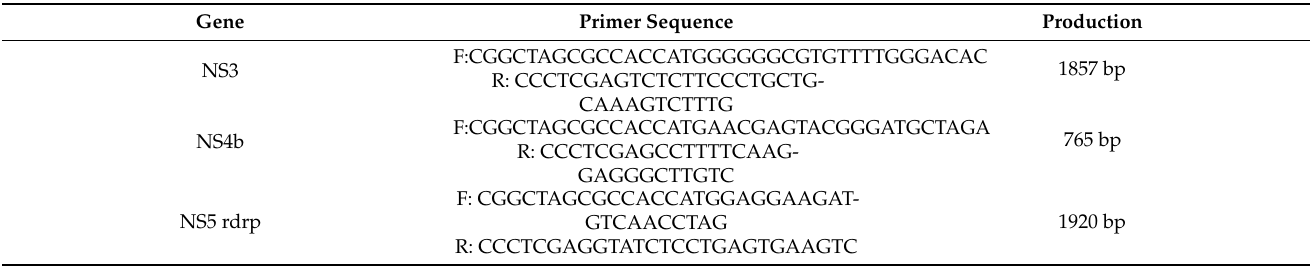
Table 1. primer used in the